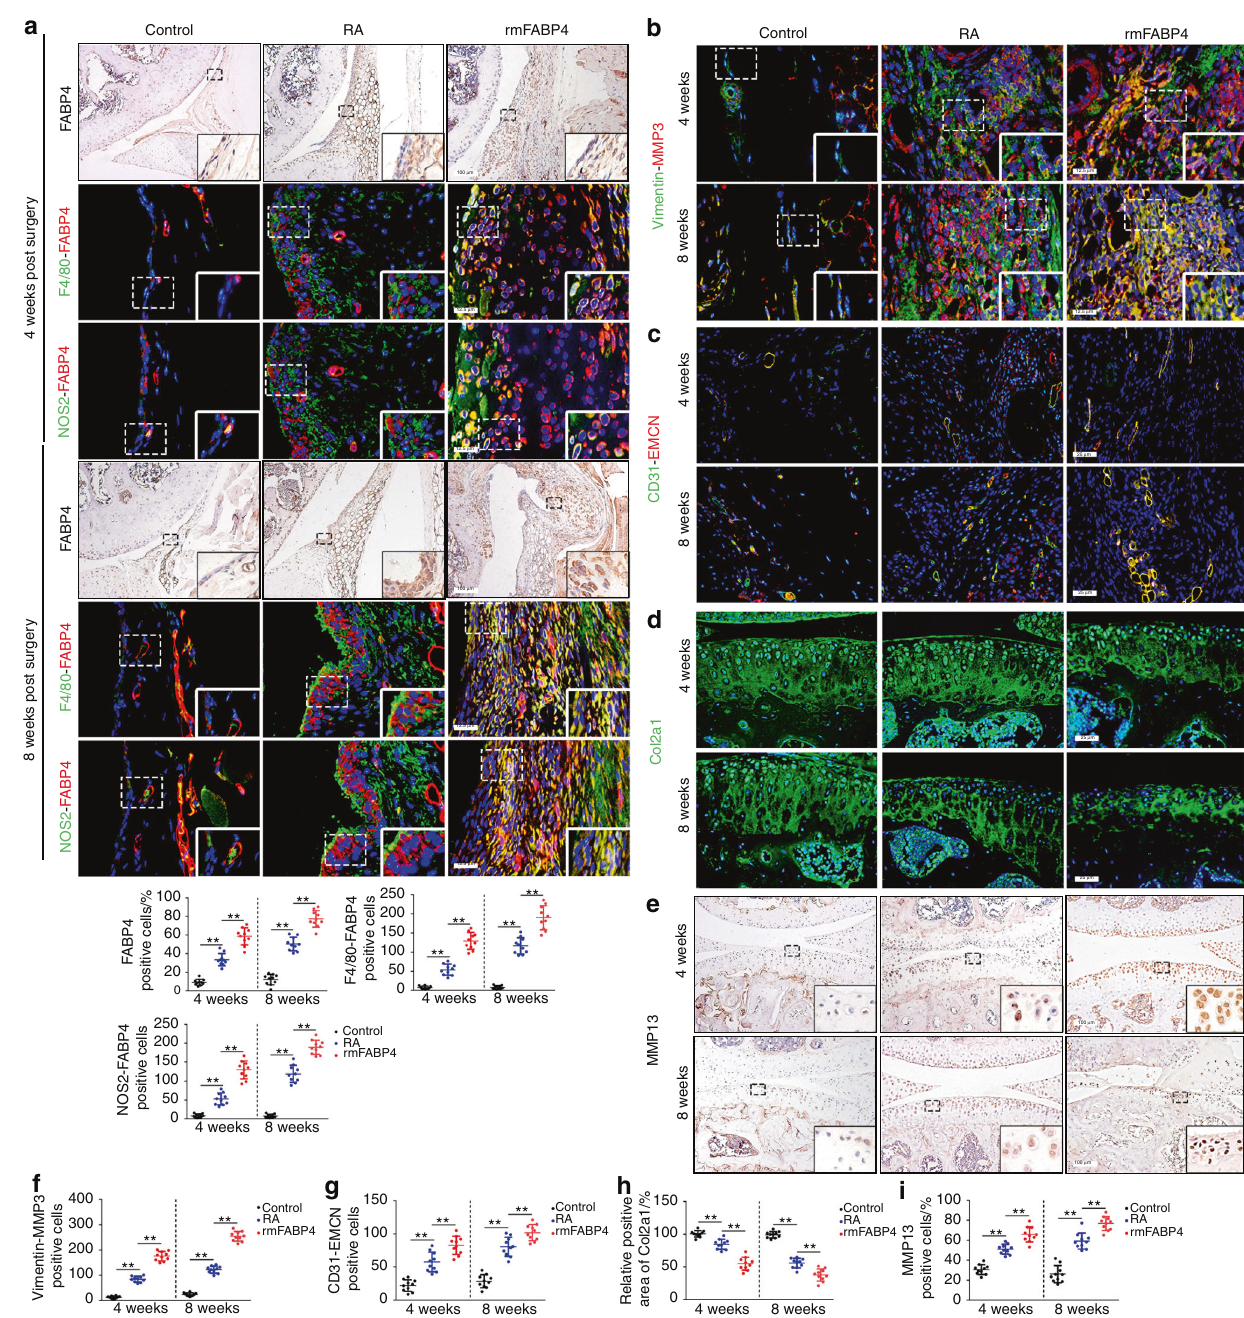
Fig. 3 Recombinant FABP4 exacerbates the development of RA in C57BL/6 J mice. a Representative images and quantitative analysis of FABP4 were assessed by immunohistochemical staining and coimmunostaining of FABP4 with F4/80 or NOS2 in the synovium of control and RA mice treated with vehicle or rmFABP4 for 4 and 8 weeks ( n = 10 per group). Scale bars: 12.5 µm and 100 µm. b – i Representative images and quanti fi cation of Vimentin and MMP3 coimmunostaining ( b , f ), CD31 and EMCN coimmunostaining ( c , g ), Col2a1 immuno fl uorescence staining ( d , h ), and MMP13 immunohistochemical staining ( e , i ) in the knee joints of control and RA mice treated with vehicle or rmFABP4 for 4 and 8 weeks ( n = 10 per group). Scale bars: 12.5 µm, 25 µm, and 100 µm. One-way ANOVA and Tukey ’ s multiple comparison test. ** P < 0.01. The data are shown as the mean ± SEM neutrophils. Notably, we found that the expression of p-S6, NOS2 used as a model to investigate the role of M1-polarized and FABP4 in the BMDMs of TSC1KO mice was signi fi cantly macrophages. 13,24 To determine whether mTORC1 activation con- upregulated compared to that in controls (Fig. 4h). Synovial tributes to macrophage polarization in the synovium, we generated macrophages exhibited increased activation of mTORC1 (Fig. 4i), mice (TSC1KO) with conditional ablation of the tuberous sclerosis as well as signi fi cant increases in M1-like polarization and FABP4 complex 1 (TSC1) gene in myeloid cells using a Cre expression expression (Fig. 4j) in the synovium in TSC1KO mice after AIA cassette under the control of the lysozyme proximal promoter. 25 modeling compared to their littermate controls. HE staining showed Thus, the target gene was speci fi cally ablated in macrophages and Bone Research (2022)